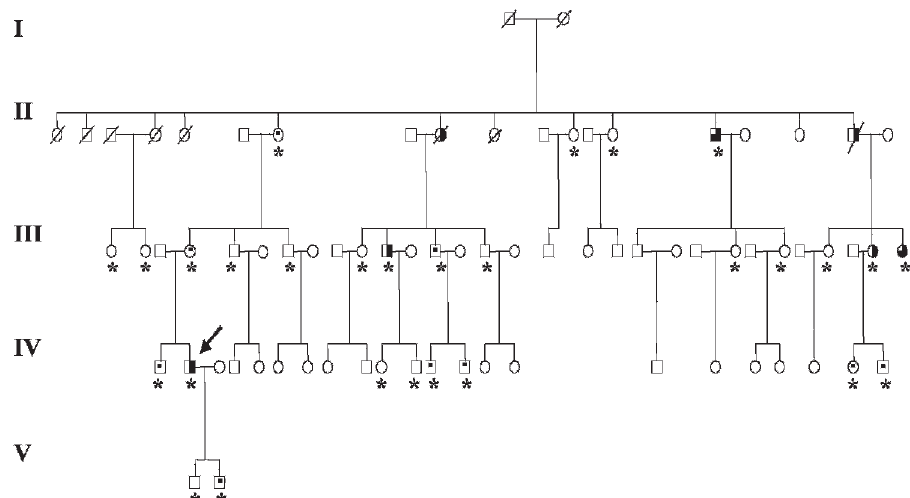
Figure 1 - Pedigree analysis. The proband is indicated by the black arrow. Deceased patients are identified by diagonal lines. Subjects with signs of MEN2A syndrome are indicated by black shading, which covers half of the pedigree symbol for patients with MTC alone and three-quarters of the symbol for patients with MTC plus PHEO. All patients who underwent genetic testing are marked with an asterisk. After genotyping, gene mutation carriers are identified by the square shape of their respective